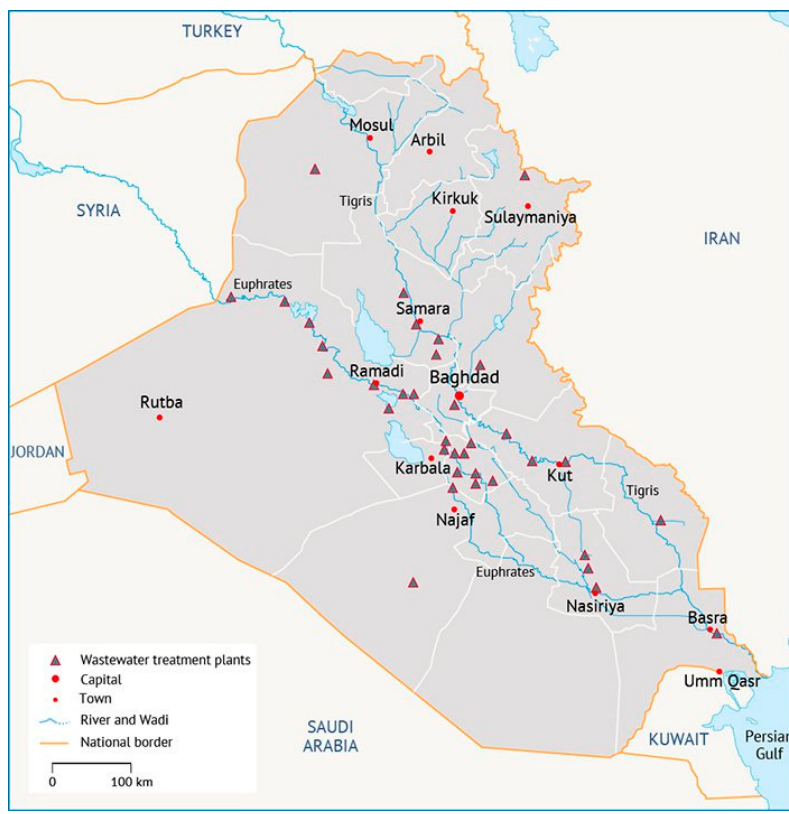
Figure 1. Locations of wastewater treatment plants in Iraq [41].